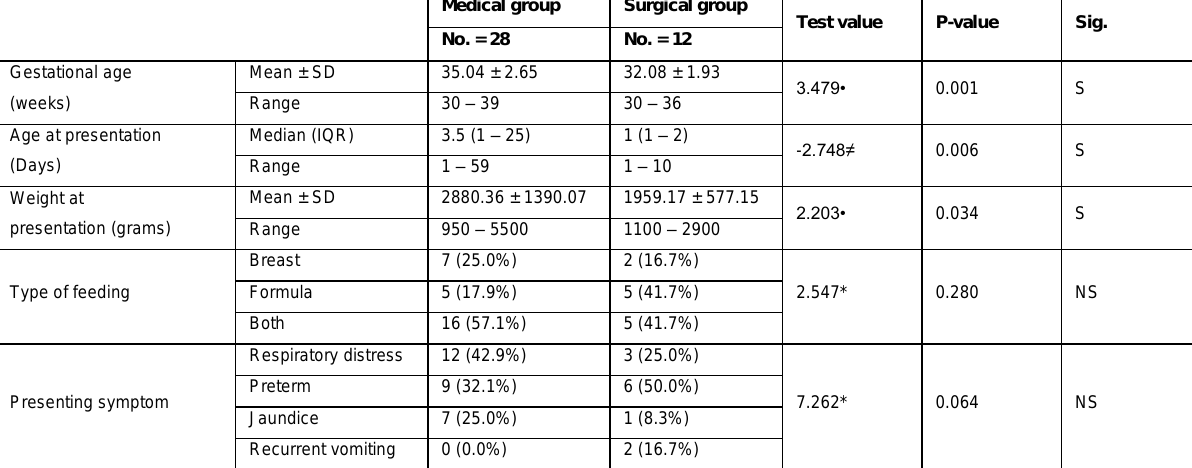
Table 1: Comparison between the medical group and the surgical group regarding demographic data at the time of